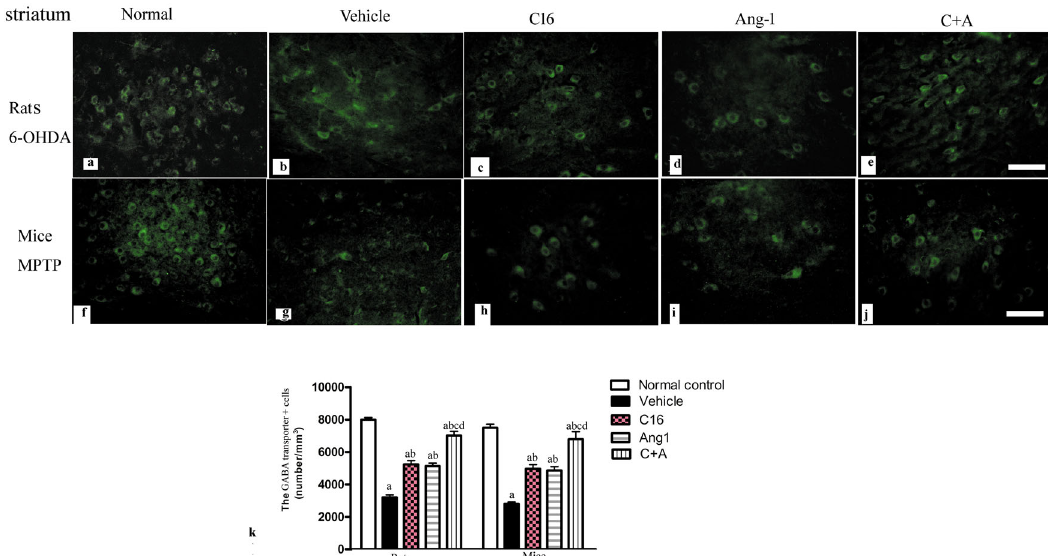
Fig. 9 C16 in combination with Ang-1 treatment rescued the GABA neurons. a – j The immunostaining of GABA transporter-positive cells (green) in the striatum showed that activated GABA was downregulated in vehicle-treated PD models compared to the normal control group ( b , g ). Treatment with C16 ( c , h ), Ang-1 ( d , i ), and the C16 plus Ang-1 treatment ( e , j ) restored GABA expression in PD animals. Scale bar = 100 µm. k Quanti fi cation of cells stained with anti-GABA transporter. a p < 0.05 versus the normal control group; b p < 0.05 versus the vehicle group; c p < 0.05 versus the C16-treated group; d p < 0.05 versus the Ang-1-treated group. GABA, gamma-aminobutyric acid; C16, peptide (KAFDITYVRLKF) that can selectively bind integrin α ν β 3 ; Ang-1